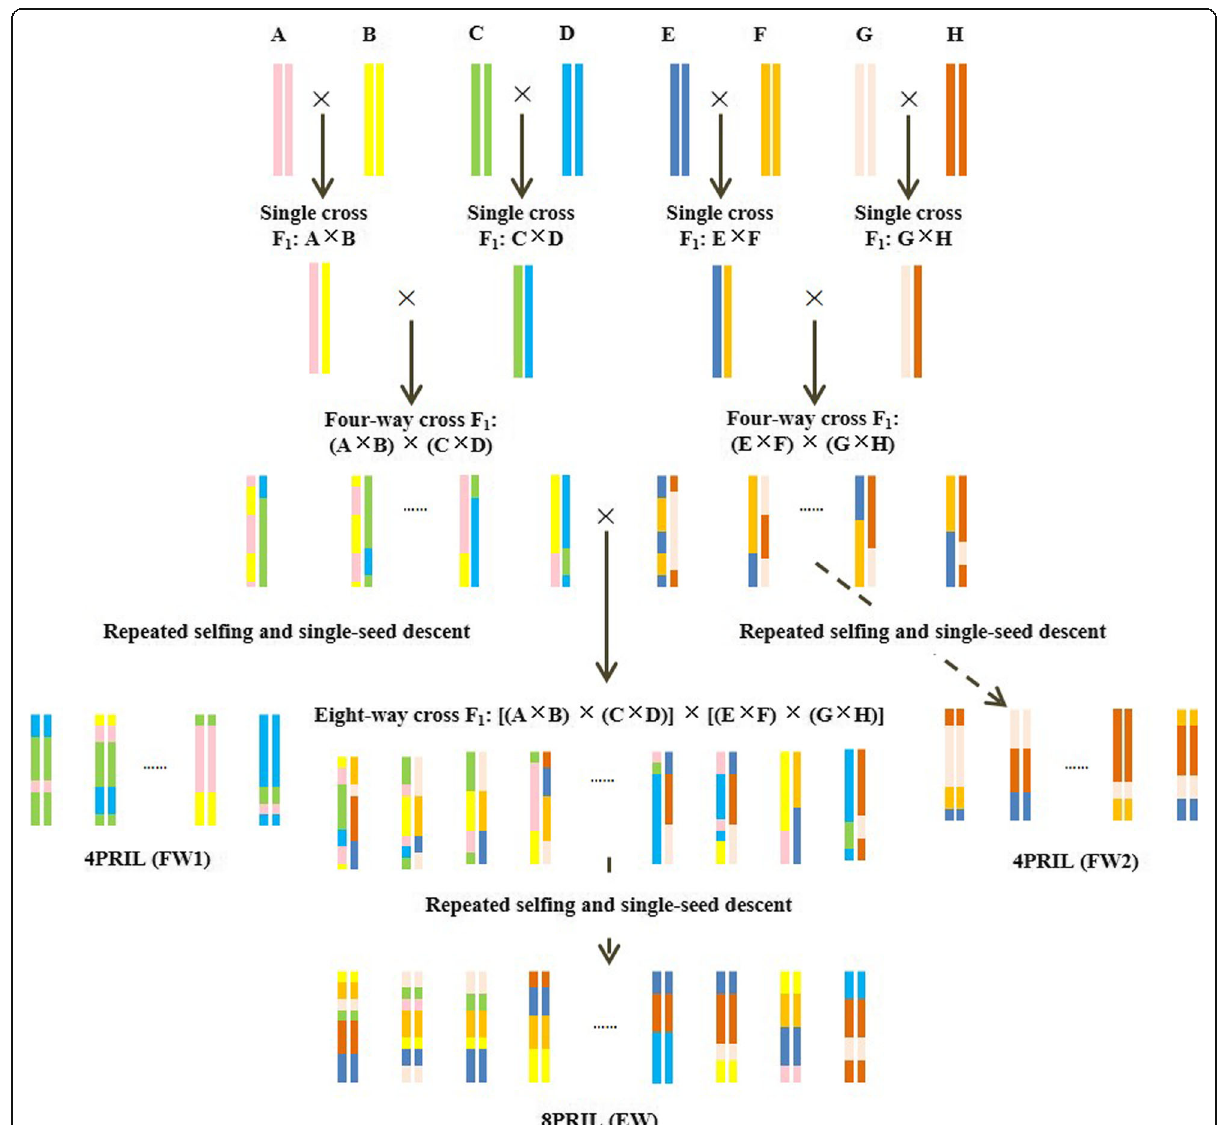
Fig. 1 Development of three multi-parent pure-line populations in